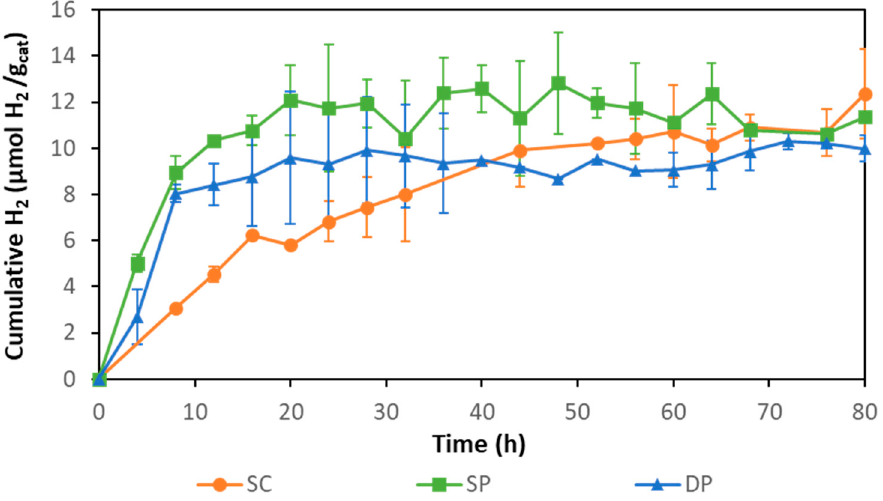
Figure 6. Hydrogen production with SC, SP, and DP photocatalytic membranes.